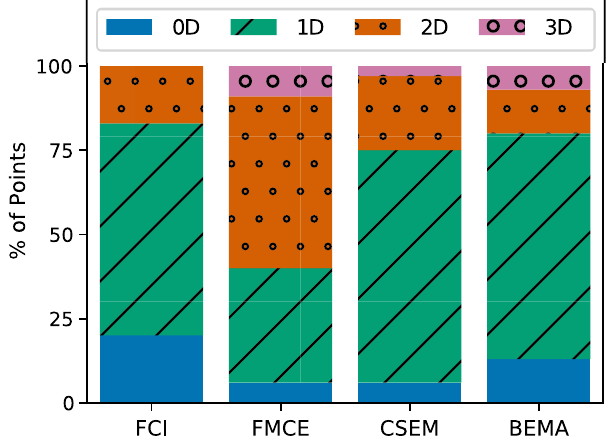
FIG. 1. Percentage of points for each concept inventory that have the potential to elicit evidence of zero, one, two, or all three dimensions.